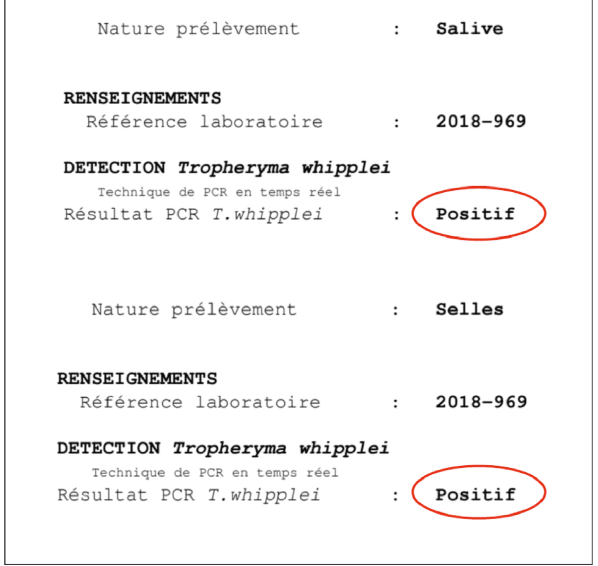
Figure 5: Tropheryma whipplei detection by PCR on saliva and stool in case number 2 (original report from the Reference Lab- oratory of Marseille,